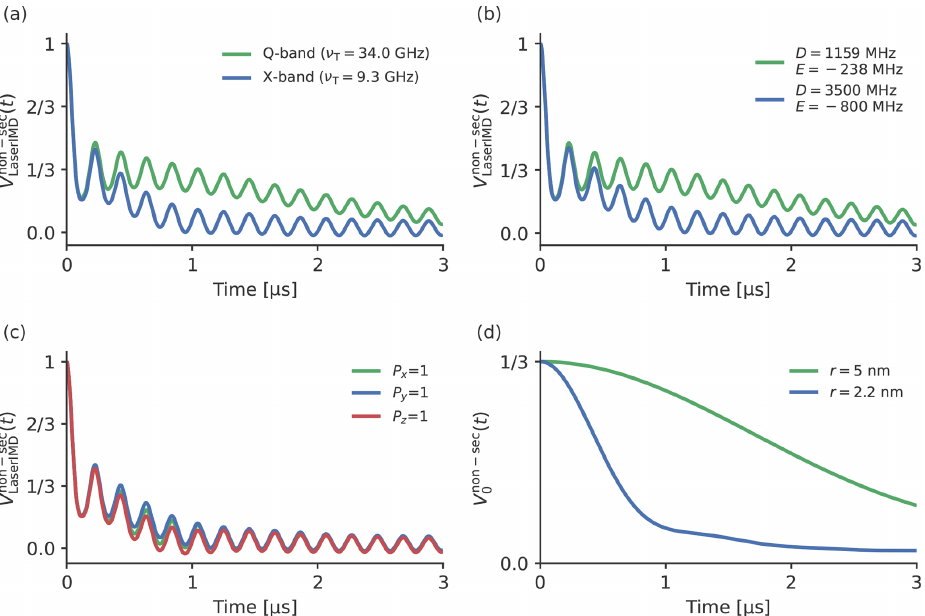
( t ) with different parameters. The following values were used for the Figure 5. A comparison of different LaserIMD traces V non-sec LaserIMD simulations. In panel (a) , TPP, r = 2 . 2nm, and ν T = 34 . 0GHz (green) and ν T = 9 . 3GHz (blue). In panel (b) , P x = 0 . 33, P y = 0 . 41 and P z = 0 . 26; r = 2 . 2nm; ν T = 9 . 3GHz; D = 1159 and E = − 238MHz (green); and D = 3500 and E = − 800MHz (blue). In panel (c) , D = 1159MHz and E = − 238MHz; r = 2 . 2nm; ν T = 9 . 3GHz; P x = 1, P y = 0 and P z = 0 (green); P x = 0, P y = 1 and P z = 0 (blue); and P x = 0, P y = 0 and P z = 1 (red). In panel (d) , TPP, ν T = 34 . 0GHz, and r = 2 . 2nm (blue) and r = 5 . 0nm (green).